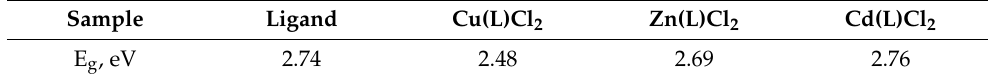
Table 1. Optical bandgaps (E g , eV) from the experimental spectra for ligand and studied complexes.